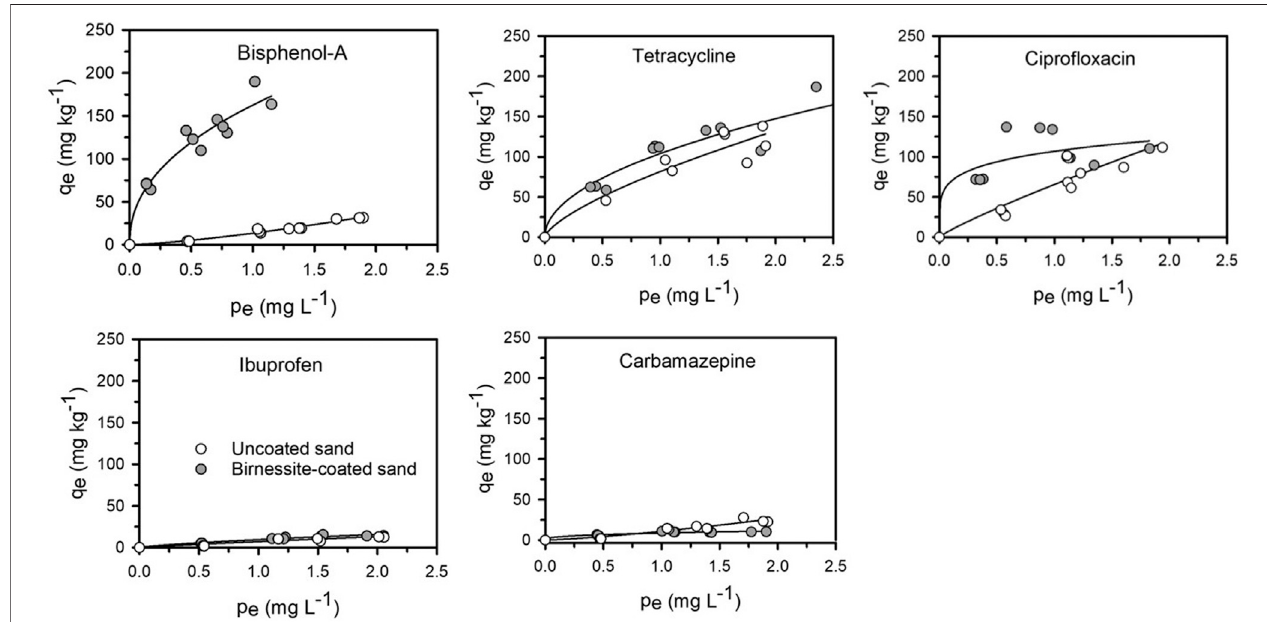
FIGURE 1 | Adsorption isotherm of PPCPs on uncoated sand and birnessite-coated sand. The lines denote the results of Freundlich modeling. q e , the amount of PPCPs absorbed at equilibrium; p e , the concentration of PPCPs in the solution at equilibrium.